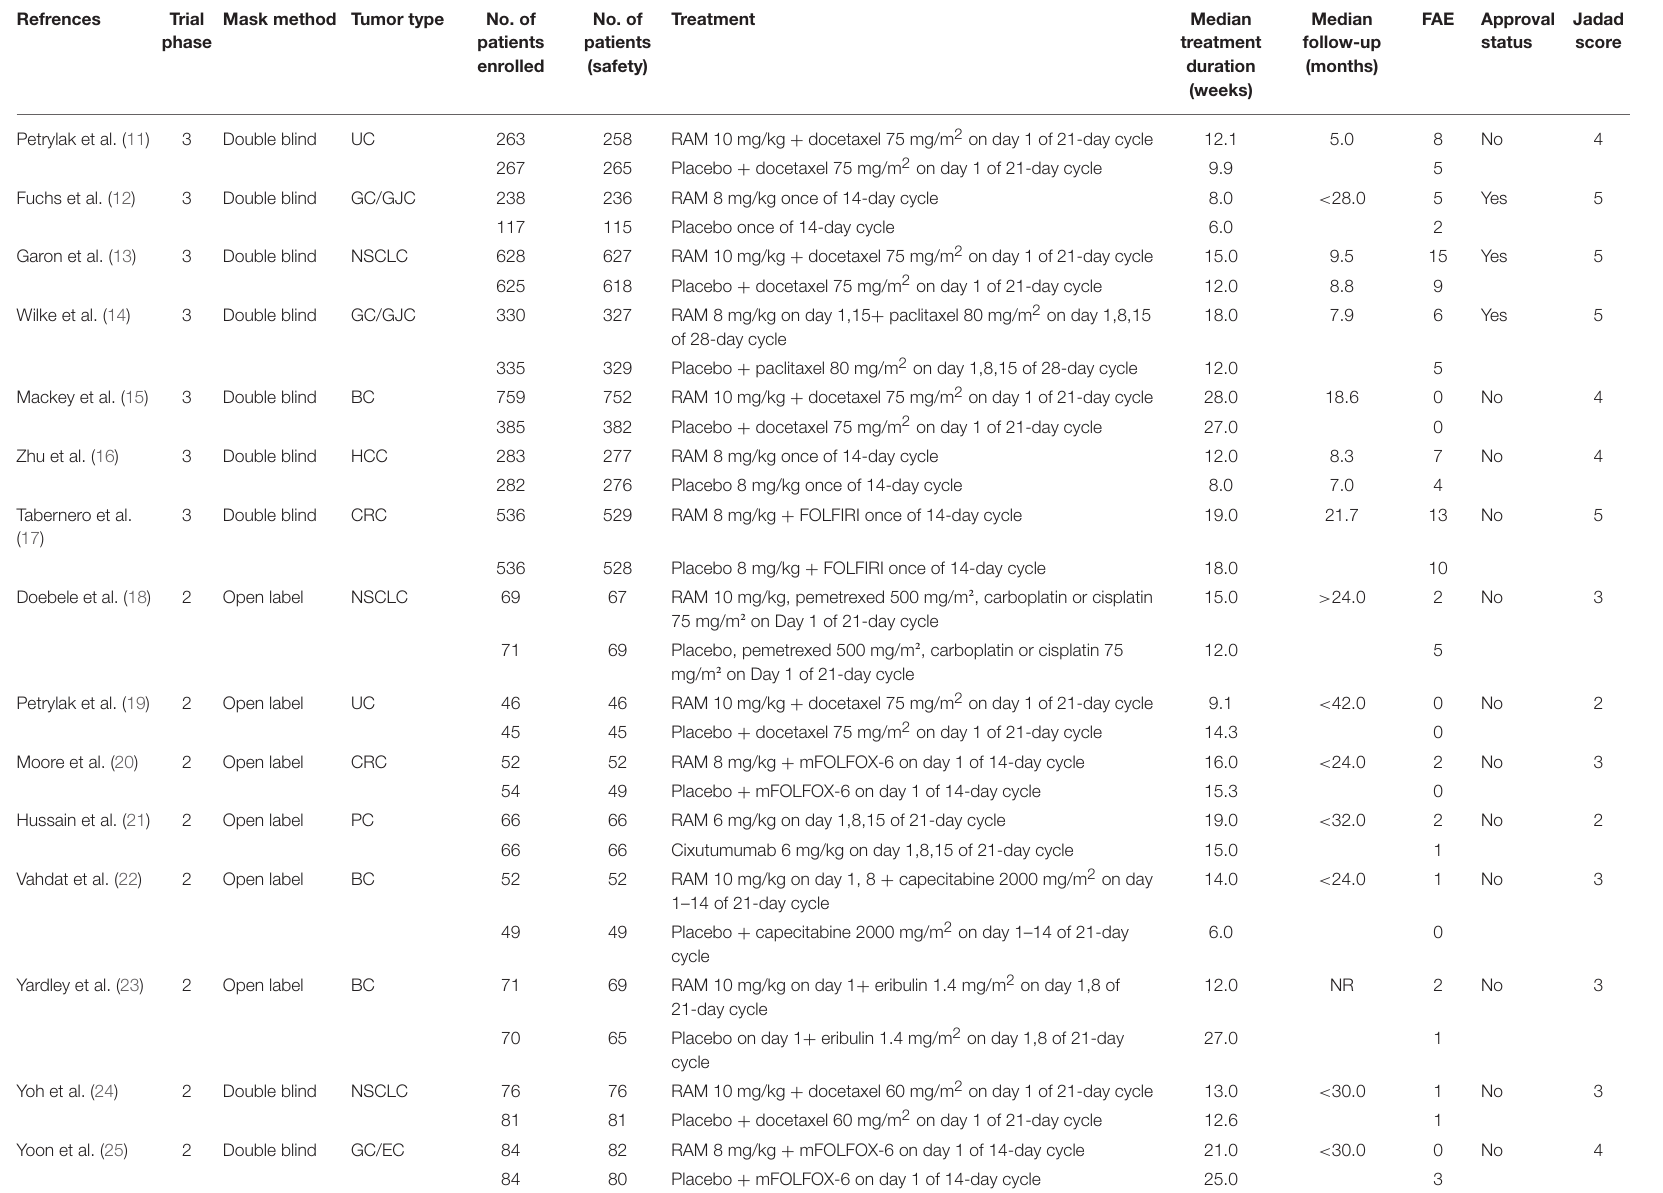
TABLE 1 | Characteristics of trials included in this